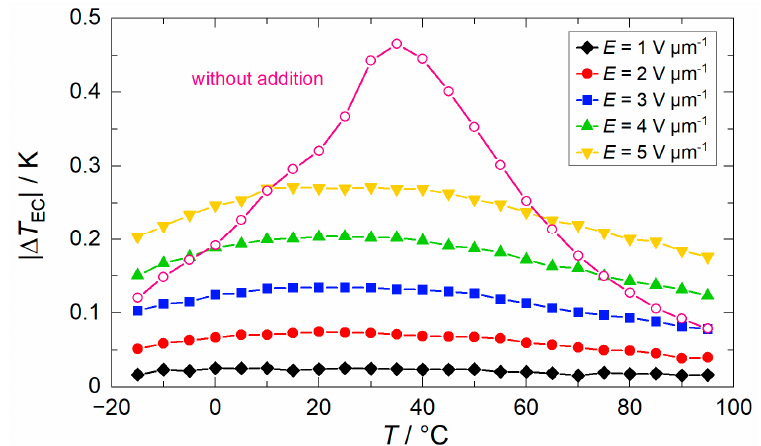
Figure 10. Electrocaloric temperature change ( | ∆ T EC | ) depending on temperature ( T ) for BSSnT-Mg measured under different electric fields (pink curve: electrocaloric temperature change ( | ∆ T EC | ) depending on temperature ( T ) for BSSnT-18-6.5 measured at ∆ E = 2 V µ m − 1 as reference). The correlation between the temperature of maximum ECE ( 𝑇 (cid:2889)(cid:2887),(cid:2923)(cid:2911)(cid:2934) ) and the temper- ature of maximum relative permi tt ivity ( 𝑇 (cid:2923) ) of BaTiO 3 -based materials (Figure 11) shows that the 𝑇 (cid:2889)(cid:2887),(cid:2923)(cid:2911)(cid:2934) is usually 5 K above 𝑇 (cid:2923) . The addition of MgO increases the gap between the 𝑇 (cid:2889)(cid:2887),(cid:2923)(cid:2911)(cid:2934) and 𝑇 (cid:2923) by 30 K. This can be explained by dielectric nonlinearity, i.e., a change in incremental permi tt ivity in certain ferroelectric compositions undergoing a strong electric fi eld [45].